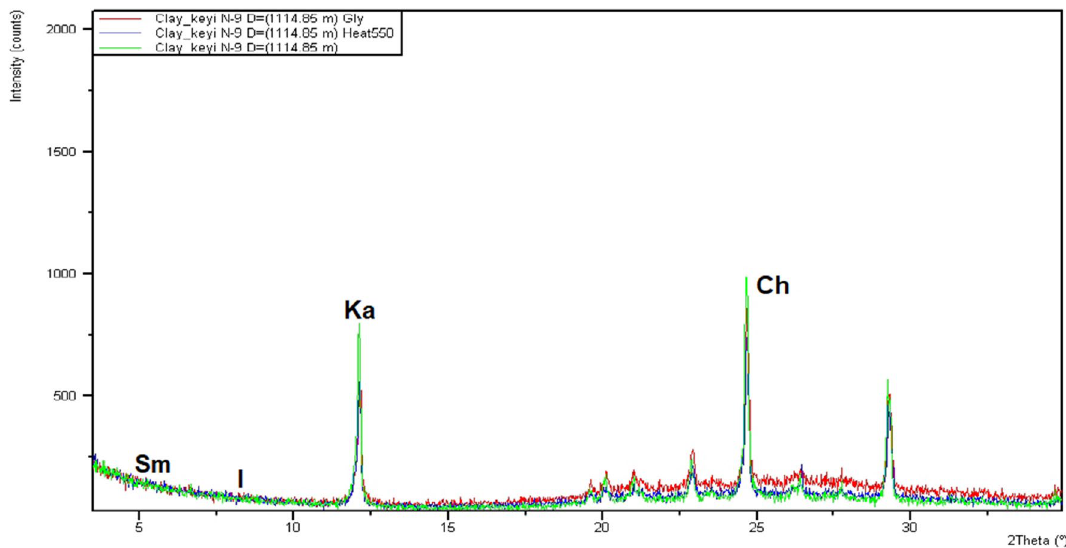
Figure 11. Representative XRD graphical charts showing the degree of crystallinity of the clay minerals present in the studied core